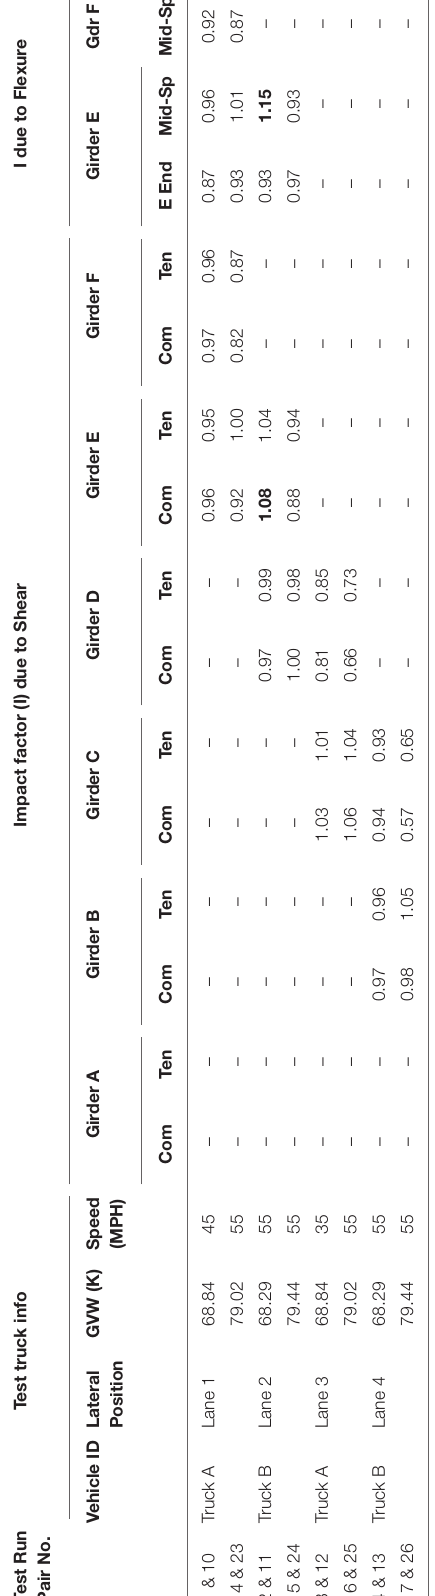
TABLE 4 | Live Load Factor ( γ LL ) for AASHTO LRFR and LFR